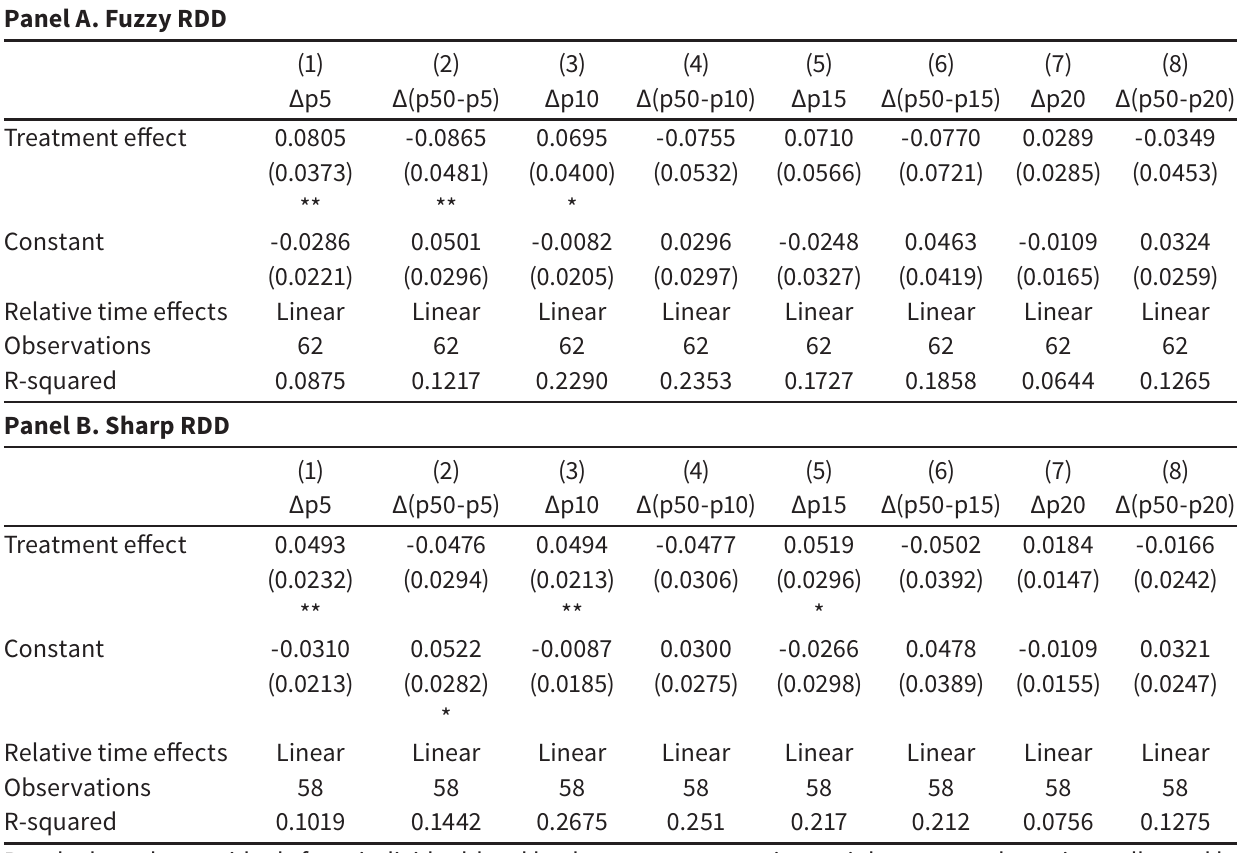
Table 6 Results on inequality Panel A. Fuzzy